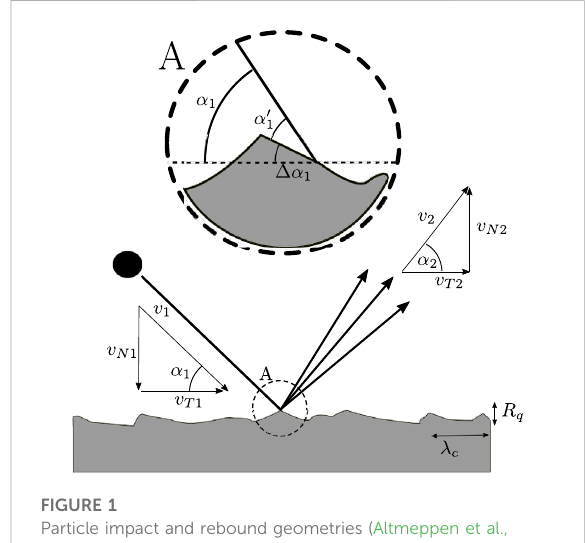
FIGURE 1 Particle impact and rebound geometries (Altmeppen et al., 2020).